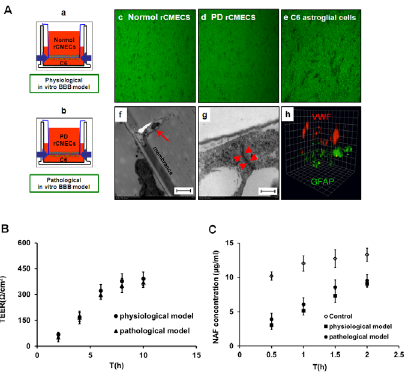
Figure 5. Characterization of the invitro BBB models. Ten days after establishing the physiological (Aa) and PD pathological (Ab) in vitro co-culture BBB models, normal rCMECs (Ac), PD rCMECs (Ad) and C6 astroglial cells (Ae) in the polyester membrane of the Transwell inserts grew in non-overlapping continuous monolayers and most endothelial cells became elongated and assumed a swirling pattern. Foot processes of C6 astroglial cells (Af, arrowhead) growing upside down transmigration through collagen-coated inserts with membrane pores 0.4 m m in diameter were observed by transmission electron microscopy. Bar (Af)=20 m m. The tight junctions (Ag, arrows) bound adjacent endothelial cells together in co-cultures were detected at high magnification ( 6 150000). Bar (g)=2 m m. The expression and distribu- tion of rCMECs and C6 astroglial cells in the Transwell membrane was visualized by immunofluorescent 3D images probed for vWF (red) and GFAP (green) (Ag, on the apical cell side). 1unit =11.82 m m. Panel B: Transendothelial electrical resistance (TEER, expressed as V /cm 2 ) of the in vitro BBB models. Panel C: Endothelial permeability coefficient for sodium fluorescein (NaF Papp, expressed in 10 2 6 cm/s) of the physiological and pathological in vitro BBB models. High TEER (B) and low paracellular Papp of NaF (C) confirmed the BBB functionality of the two models for the in vitro drug permeability experiment. All data are expressed as the means 6 SD